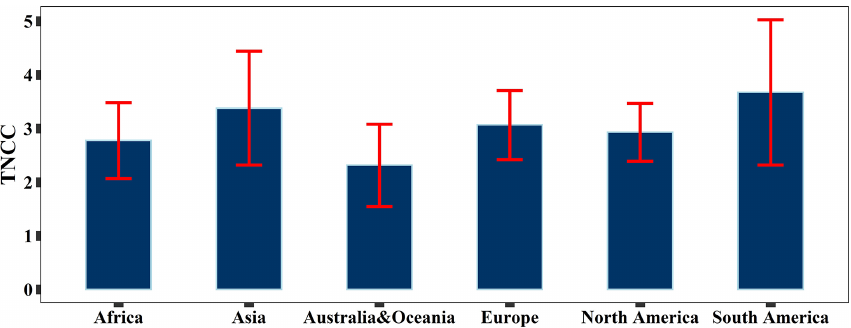
Figure 7. Statistics of GCI30-based TNCC during 2016 to 2018 at the continent level. The red line indicates the standard deviation (SD).